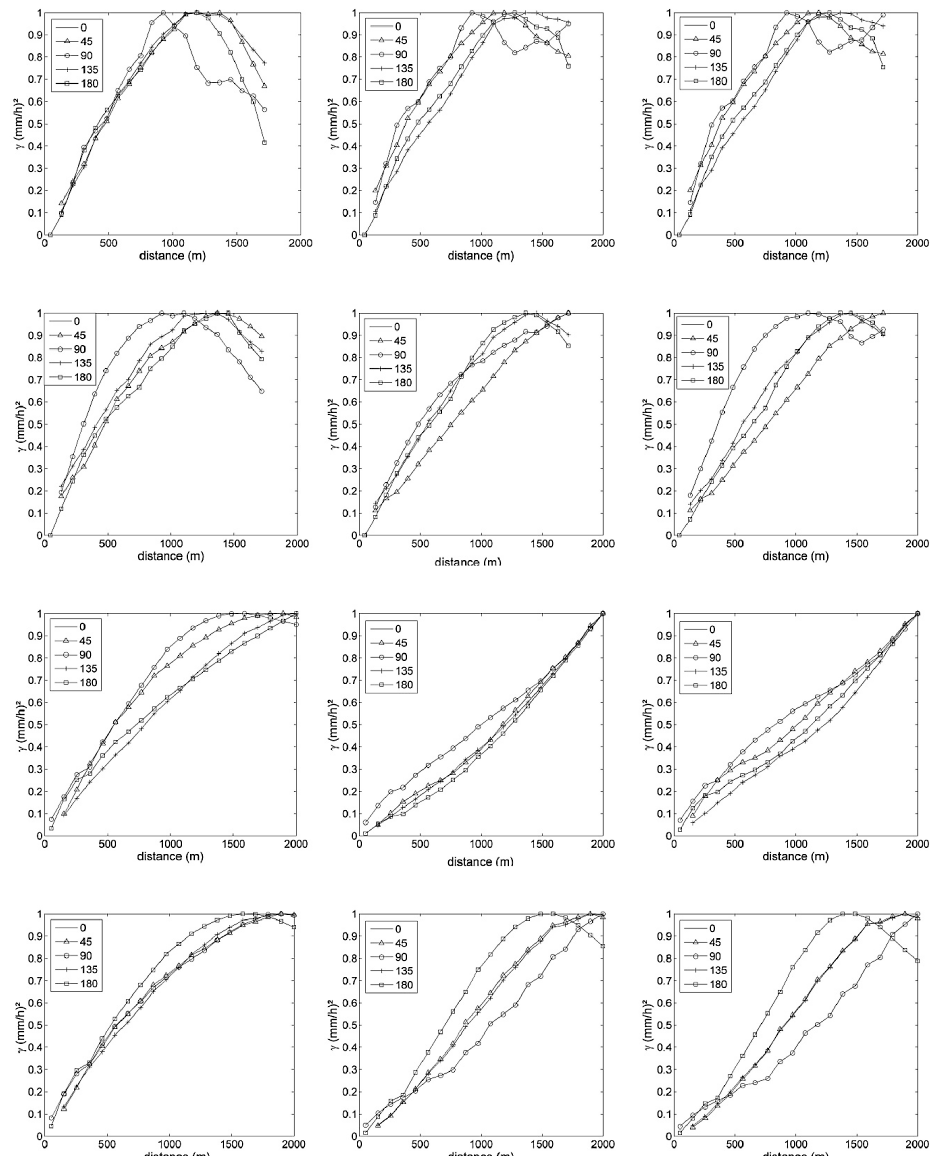
Figure 13. Anisotropic experimental semi-variograms for the four rainfall events (in rows) and different temporal resolutions: 1, 5 and 10min (left, central and right column